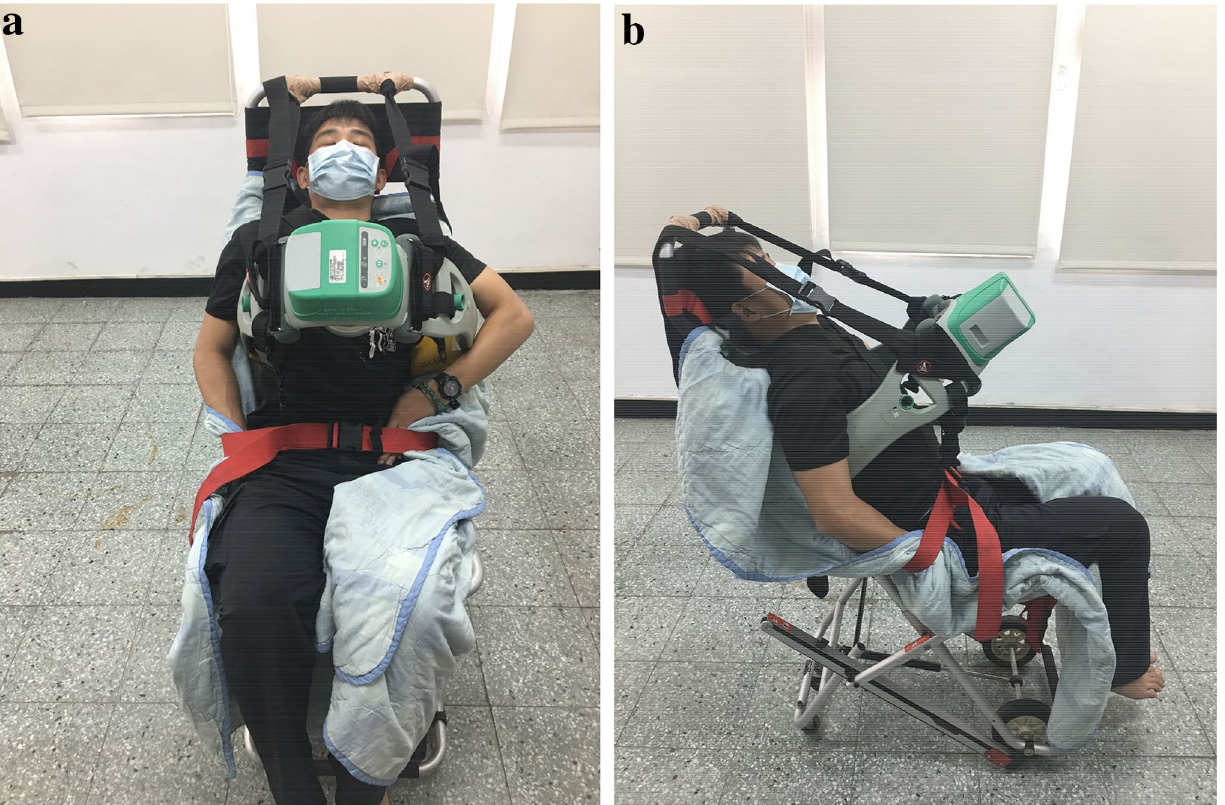
Figure 1. Adaptations of LUCAS-2 mechanical chest compression device enabling its operation in upright position during transportation. ( a ) Anterior view of simulated patient. ( b ) Lateral view of simulated patient.